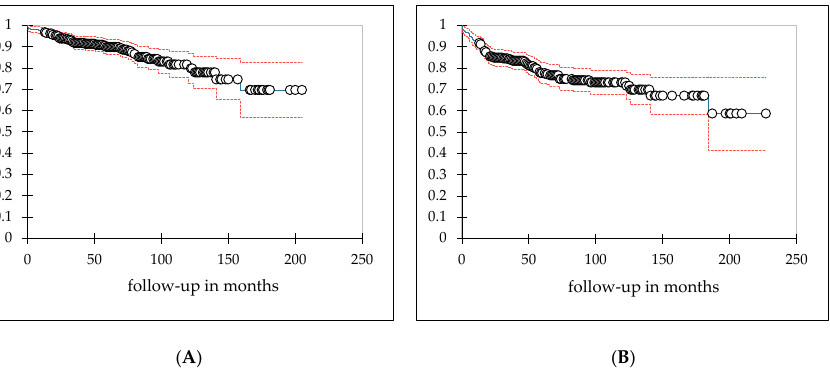
Figure 1. Landmark analysis of patients surviving at least one year after TBI-containing alloSCT. Kaplan–Meier curves for cardiac toxicity-free survival (CTFS; ( A )) and pulmonary toxicity-free survival (PTFS; ( B )) are presented above and their respective courses during follow-up, with 95%-confidence intervals, are indicated in red. Mean values were 169.6 months (M; confidence interval: 159.1–180.0 M) for CTFS and 165.6 M (confidence interval: 152.2–178.9 M) for PTFS.